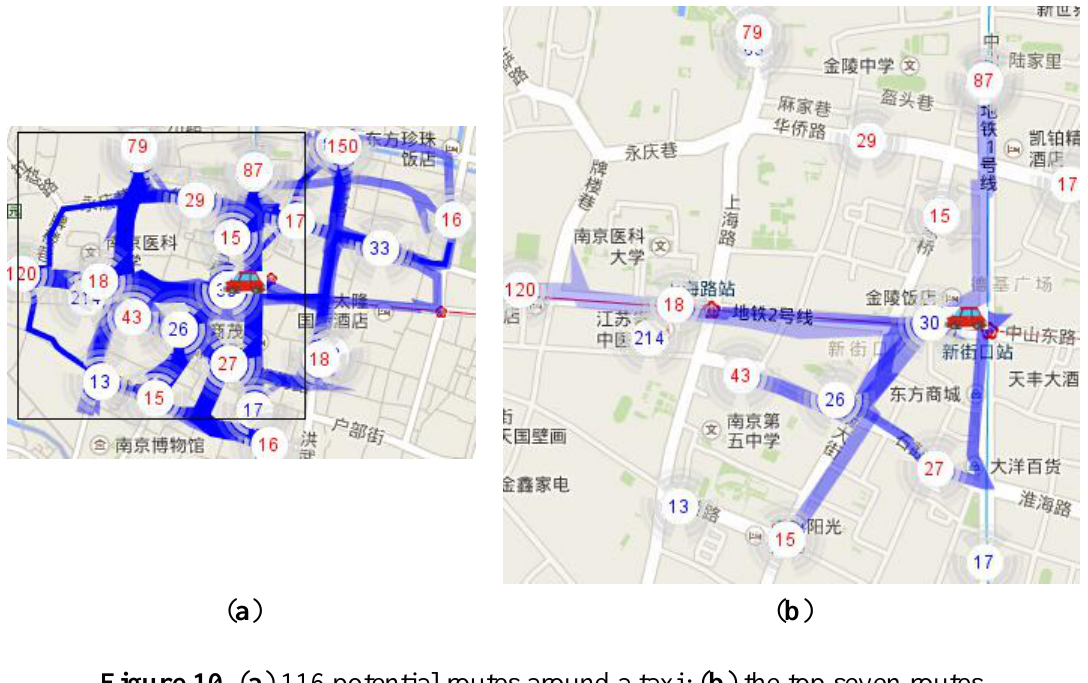
Figure 10. ( a ) 116 potential routes around a taxi; ( b ) the top seven routes. Table 1. Scores for the top seven